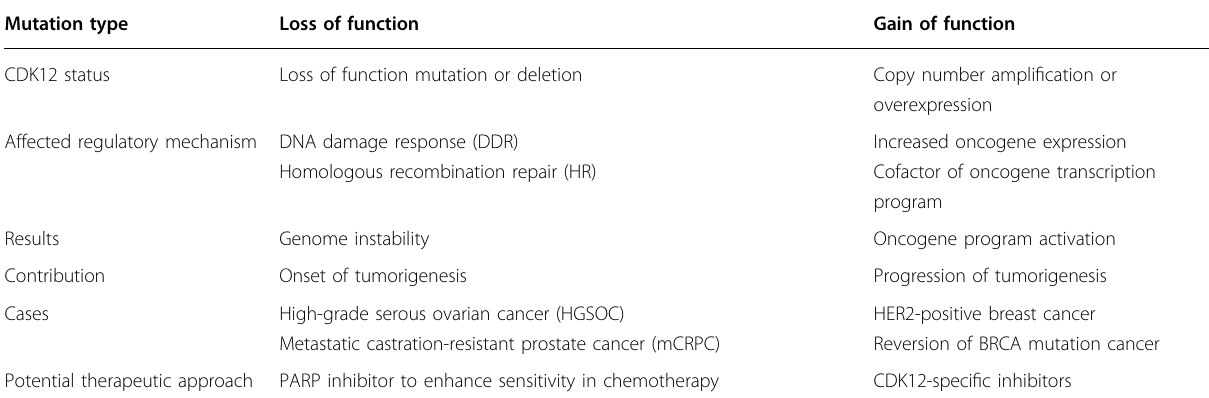
Table 1 Different functions of CDK12 in